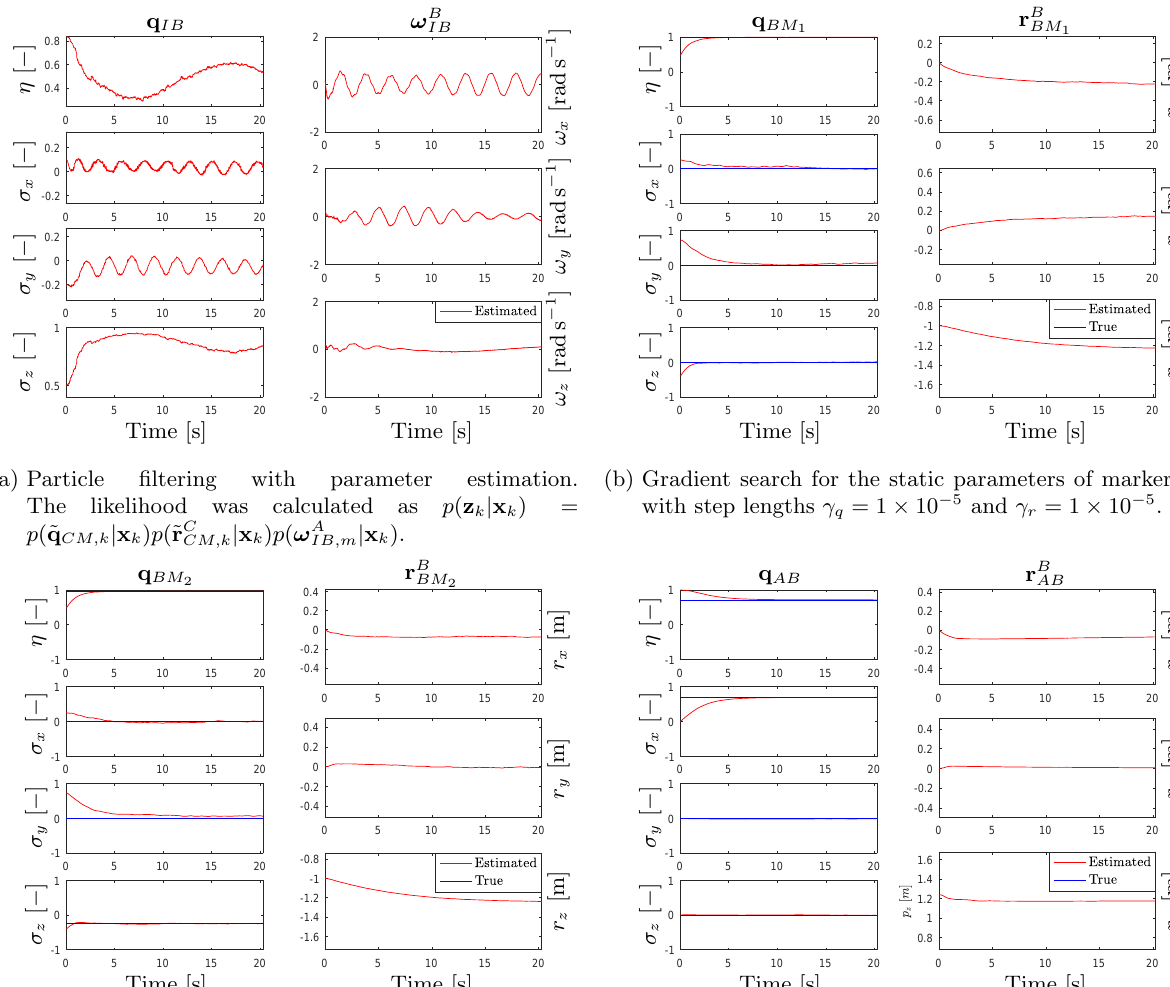
(c) Gradient search for the static parameters of marker 2 with step lengths γ q = 1 × 10 − 5 and γ r = 1 × 10 − 5 . Figure 5: Experiment with parameter estimation. The plots show the results when the static parameters were initially